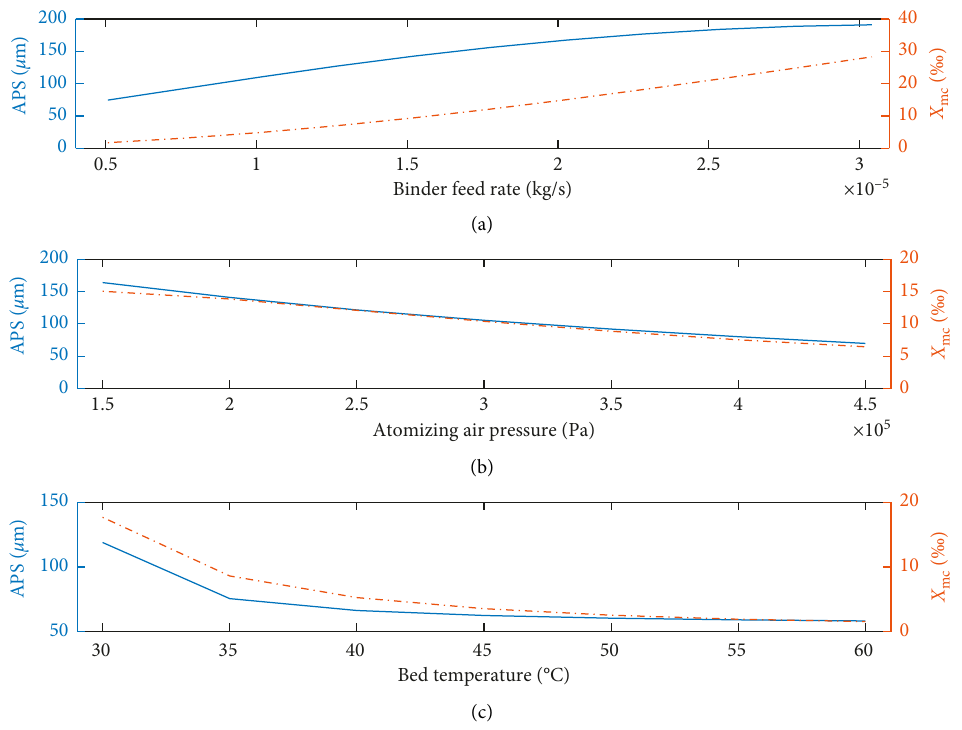
Figure 9: The simulation results for SFBG: influences of process